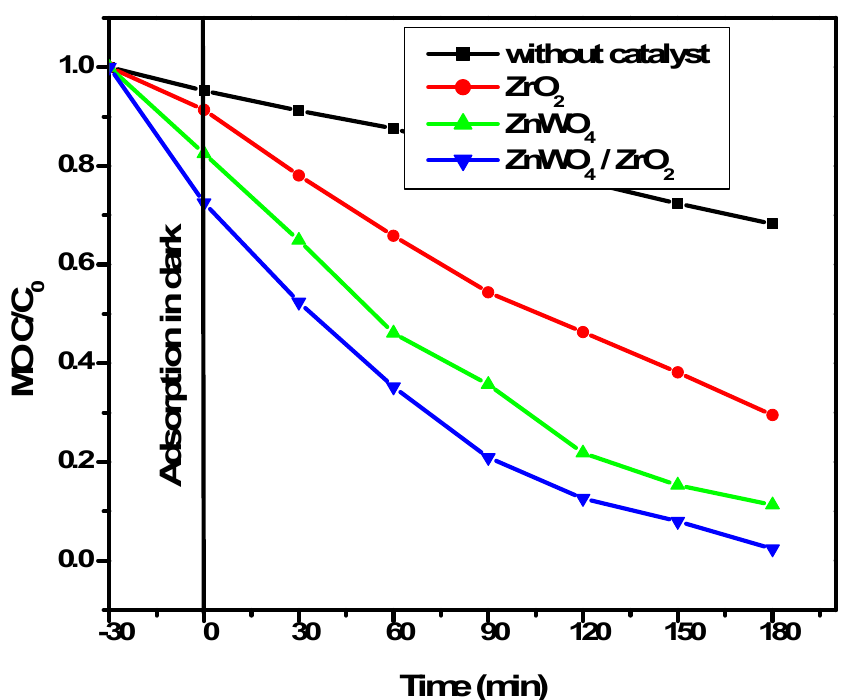
Fig. 7. Photodegradation of MO in the presence of ZrO